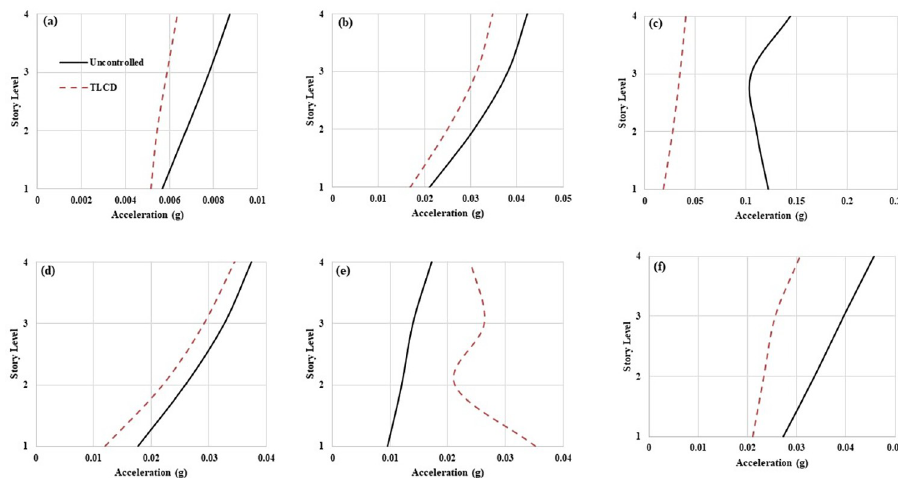
Fig 7. RMS acceleration responses of MDOF structure equipped with and without TLCD at (a) 0.65 Hz, (b) 1.17 Hz, (c) 1.3 Hz, (d) 1.43 Hz, (e) 1.95 Hz, and (f) Seismic loading.